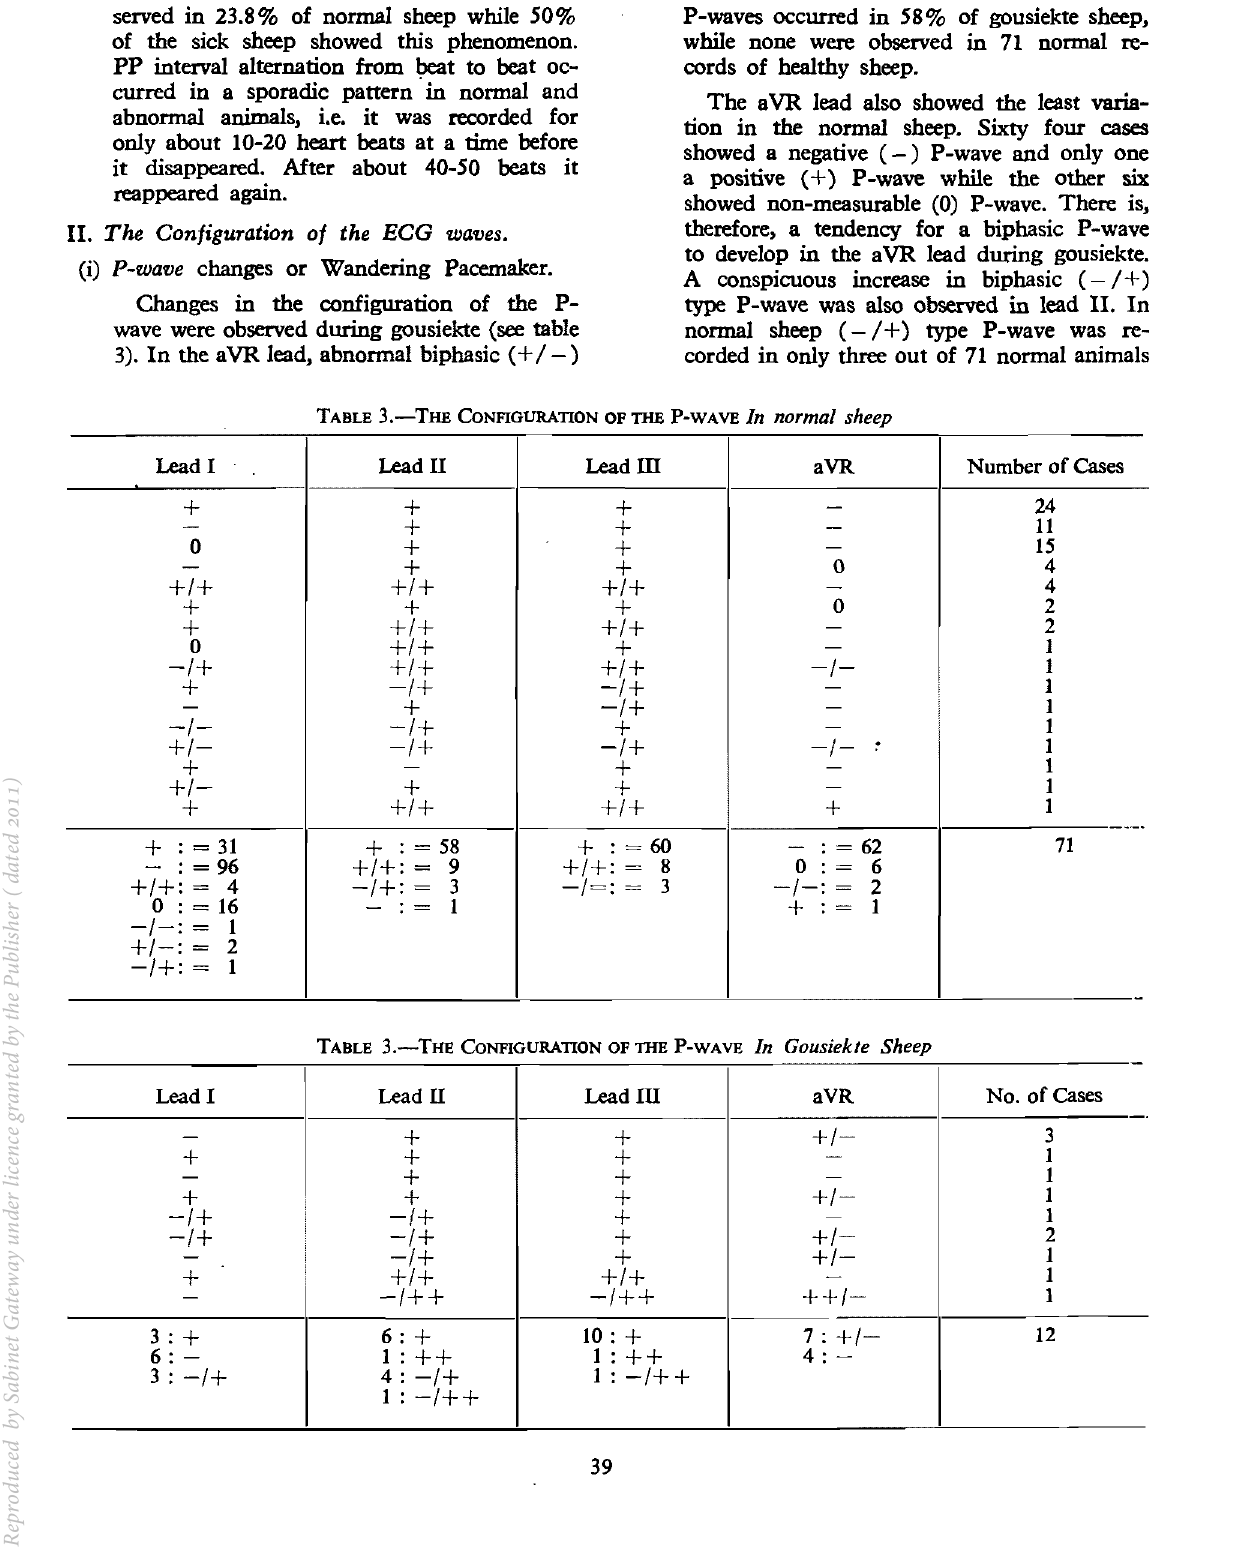
TABLE 3.-THE CONFIGURATION OF THE P-WAVE In normal sheep